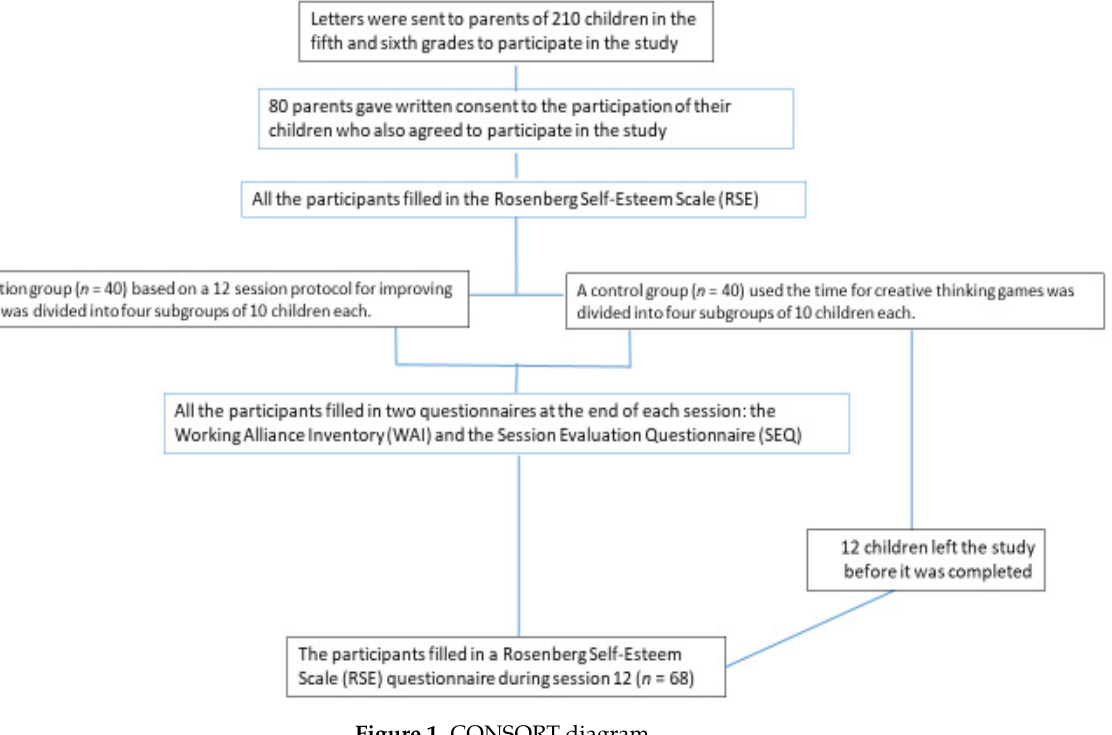
Figure 1. CONSORT Figure 1. CONSORT diagram.